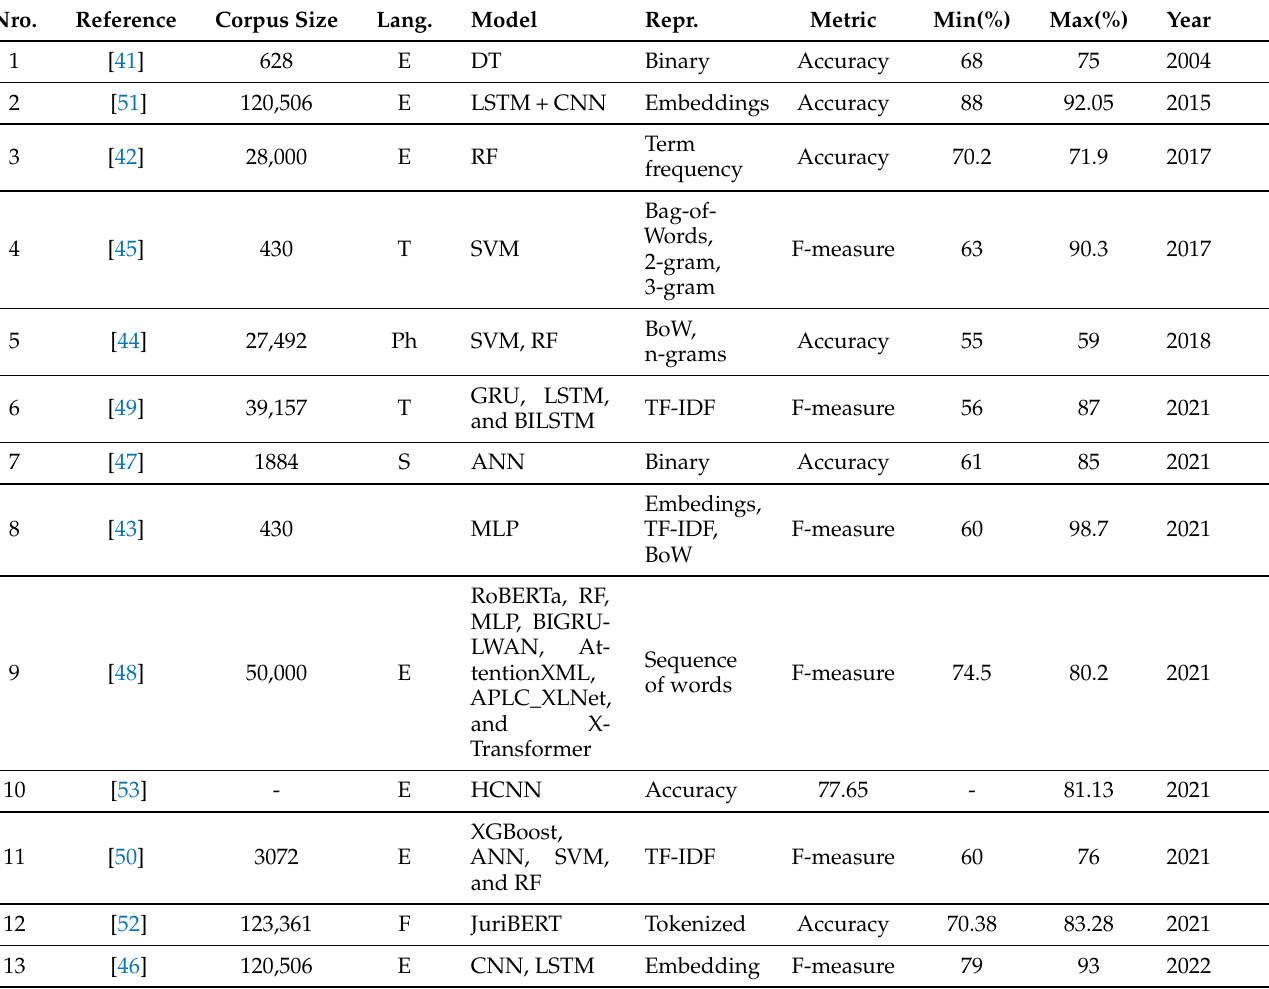
Table 2. Summary of ruling decision prediction in Constitutional Law and Supreme Courts cases, where E = English, Fa = Farsi, F = French, Ph = Philippine, S = Spanish, and T =